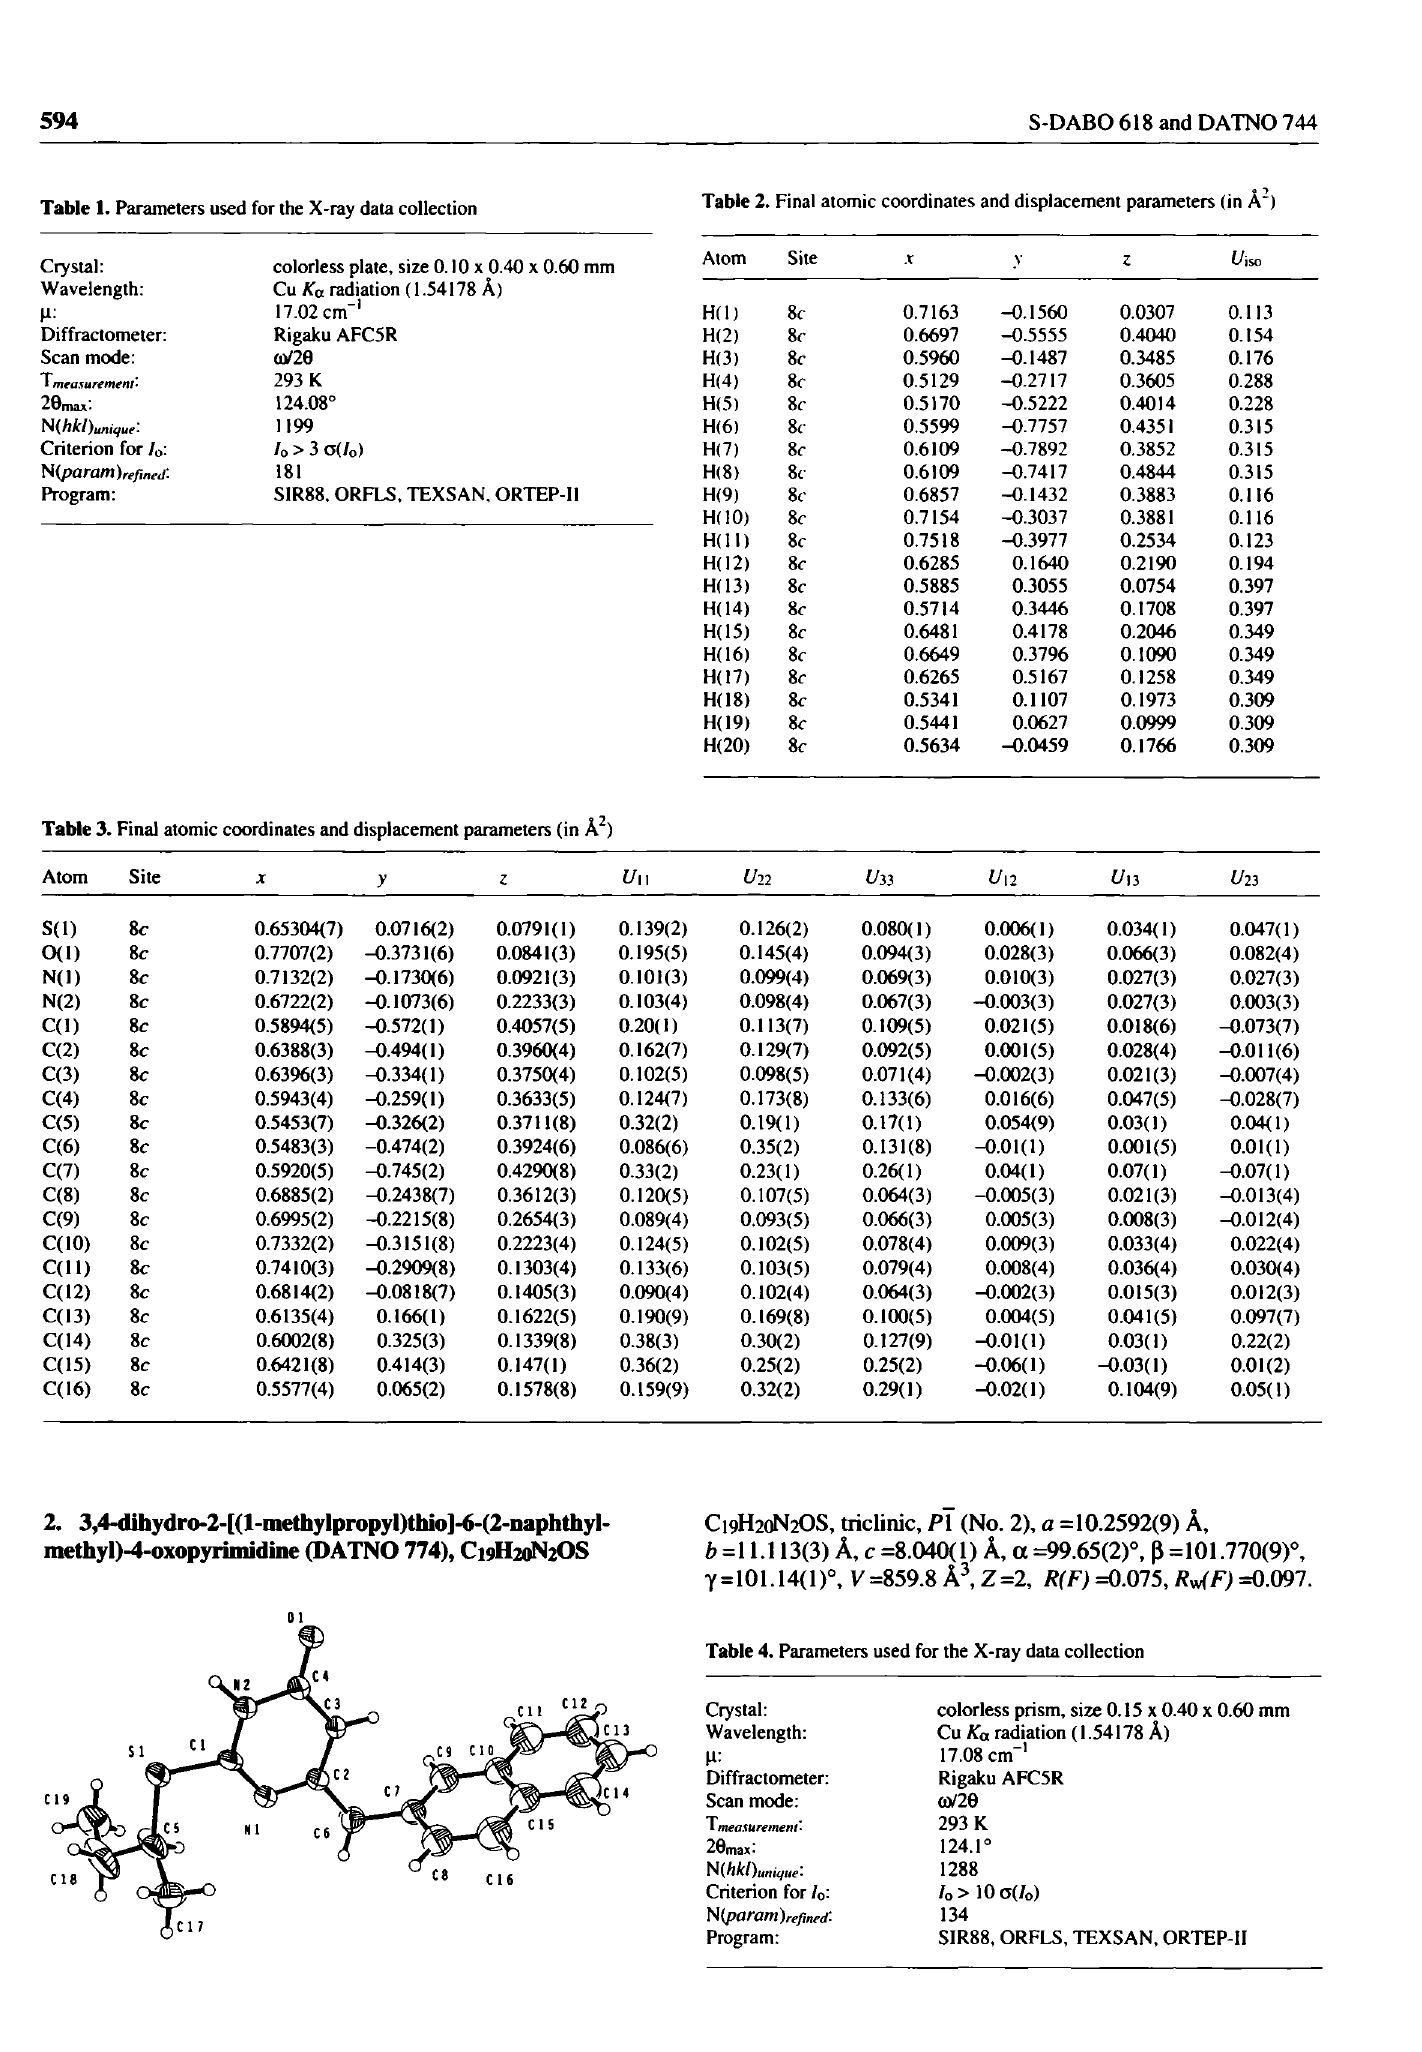
Table 4. Parameters used for the X-ray data